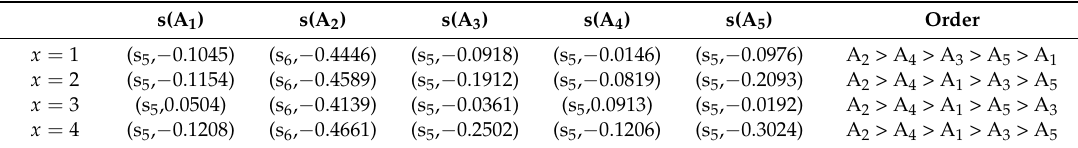
Table 8. Order for different parameters of 2TLPFWHM operator.